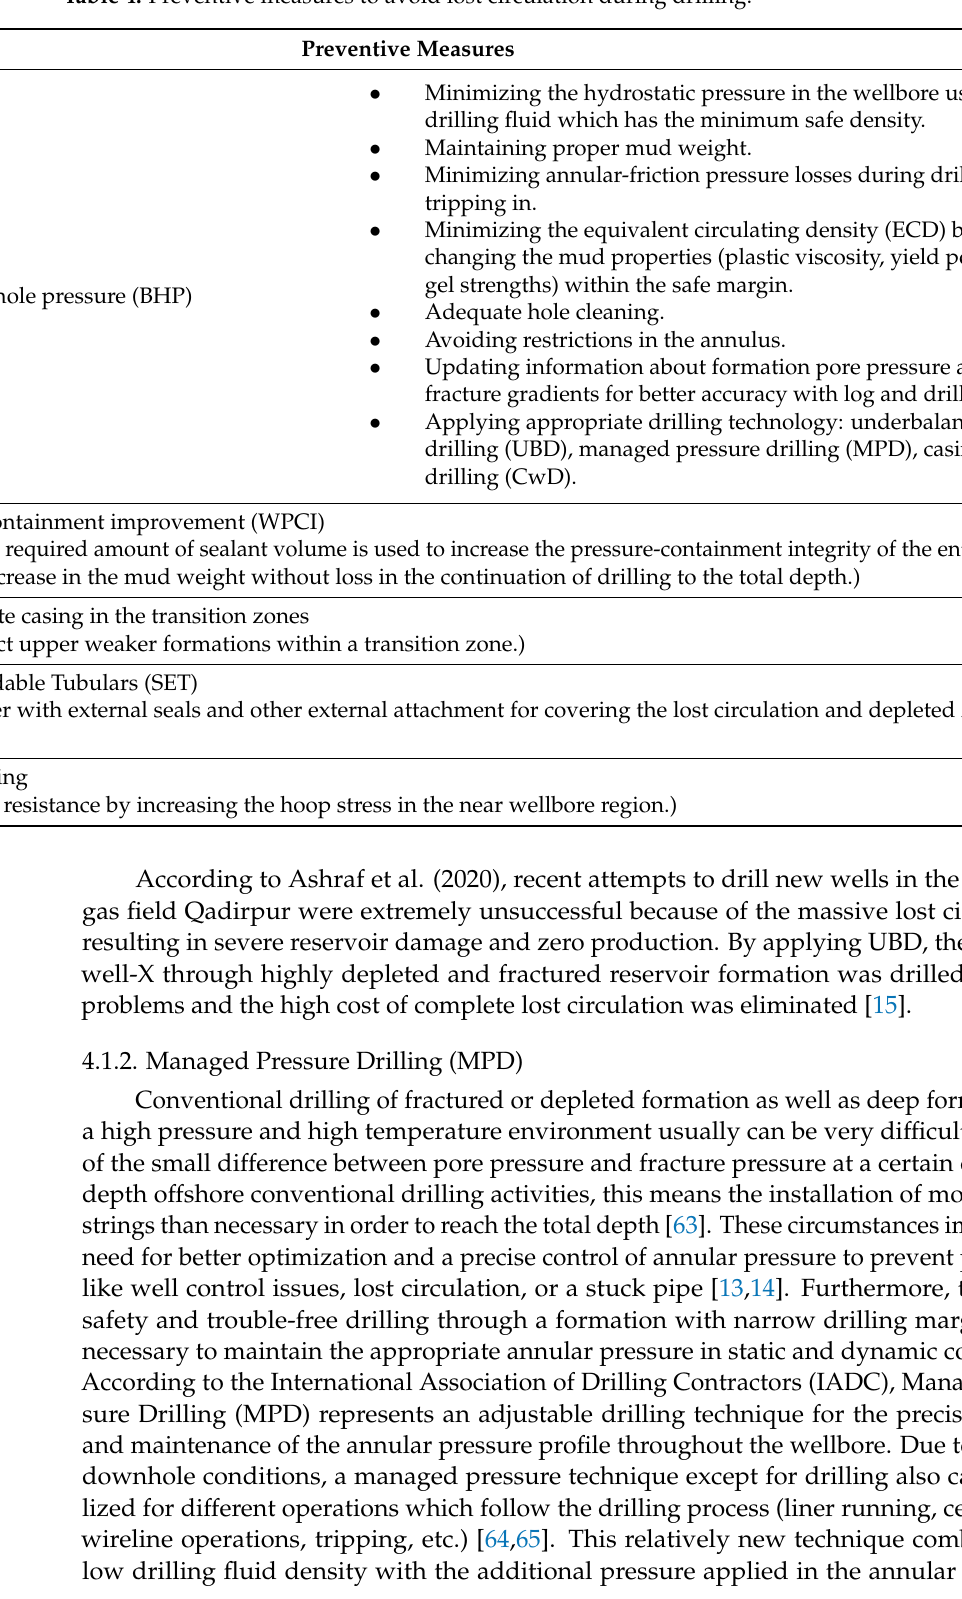
Table 4. Preventive measures to avoid lost circulation during